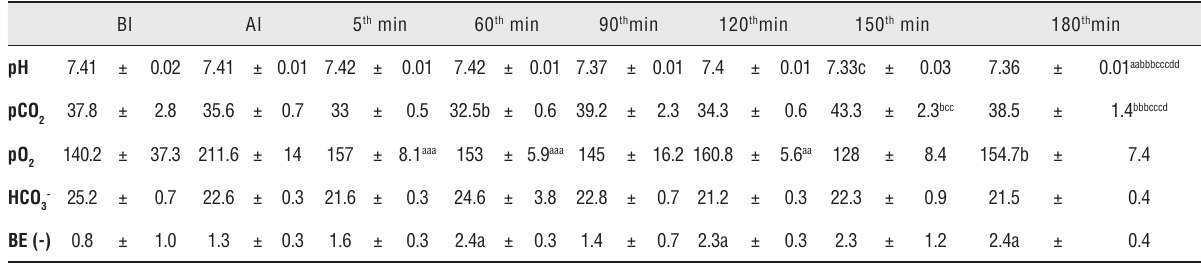
Table 2 - blood gases parameters.